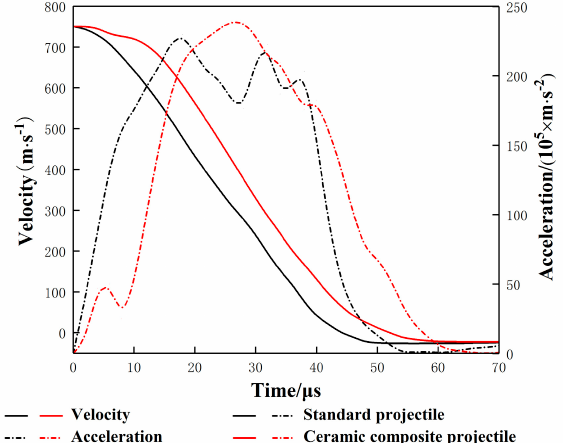
Figure 17. Projectile Core Velocity/Acceleration–Time Curve.